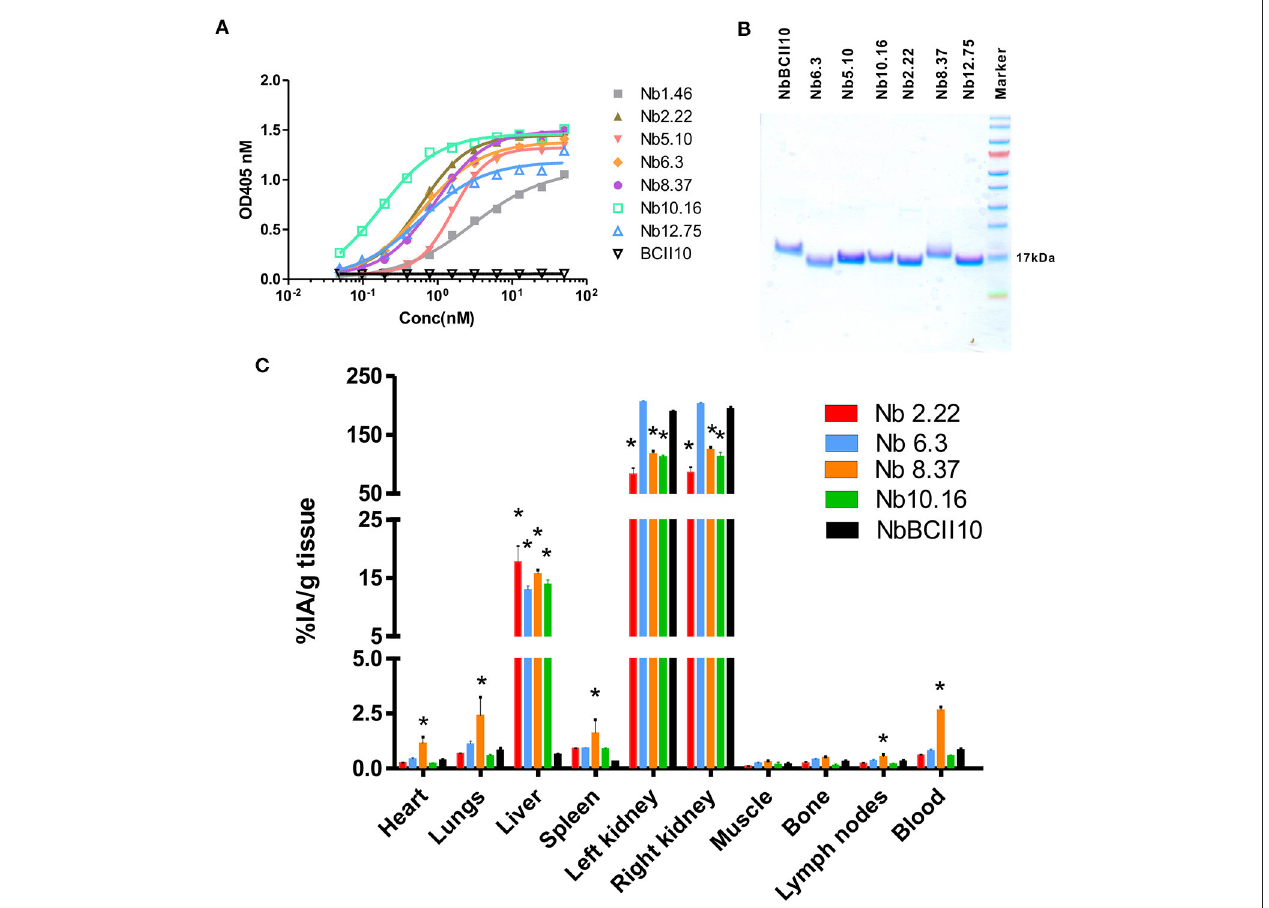
FIGURE 5 | Binding characteristics of Clec4F nanobodies. (A) Binding of increasing concentrations of Clec4F nanobodies was tested on recombinant Clec4F protein using ELISA. (B) SDS-PAGE confirmed the purity and size of selected Clec4F nanobodies after purification by size exclusion chromatography. (C) Biodistribution of radiolabeled Clec4F Nanobodies in naive mice. Four distinct 99m Tc-Clec4F nanobodies and 99m Tc-NbBCII10 control Nb were injected in naive mice (mean of 3 mice ± SEM). Radioactive content of each organ was measured in a γ -counter and expressed for each Nb as a percentage of injected radioactivity per gram of tissue (%IA/g), * P < 0.001 vs. 99m Tc-NbBCII10 control